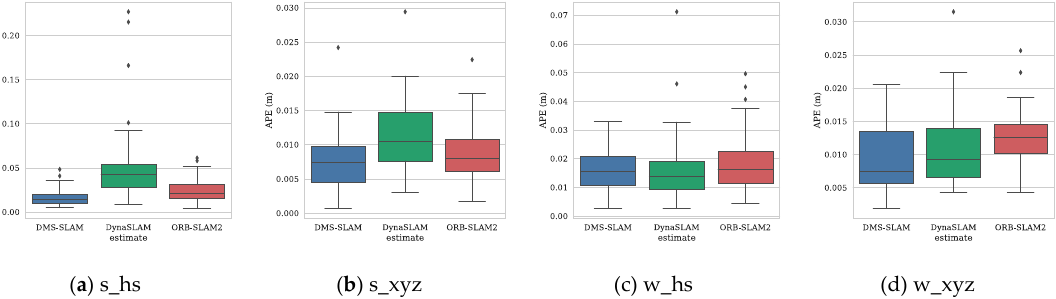
Sensors 2019 , 19 , x FOR PEER REVIEW 15 of 21 Figure 12. ( a – d ) We use Sim (3) for trajectory alignment and plot the APE distribution of the three monocular vision SLAM systems in low dynamic (s_*) and high dynamic (w_*) datasets.